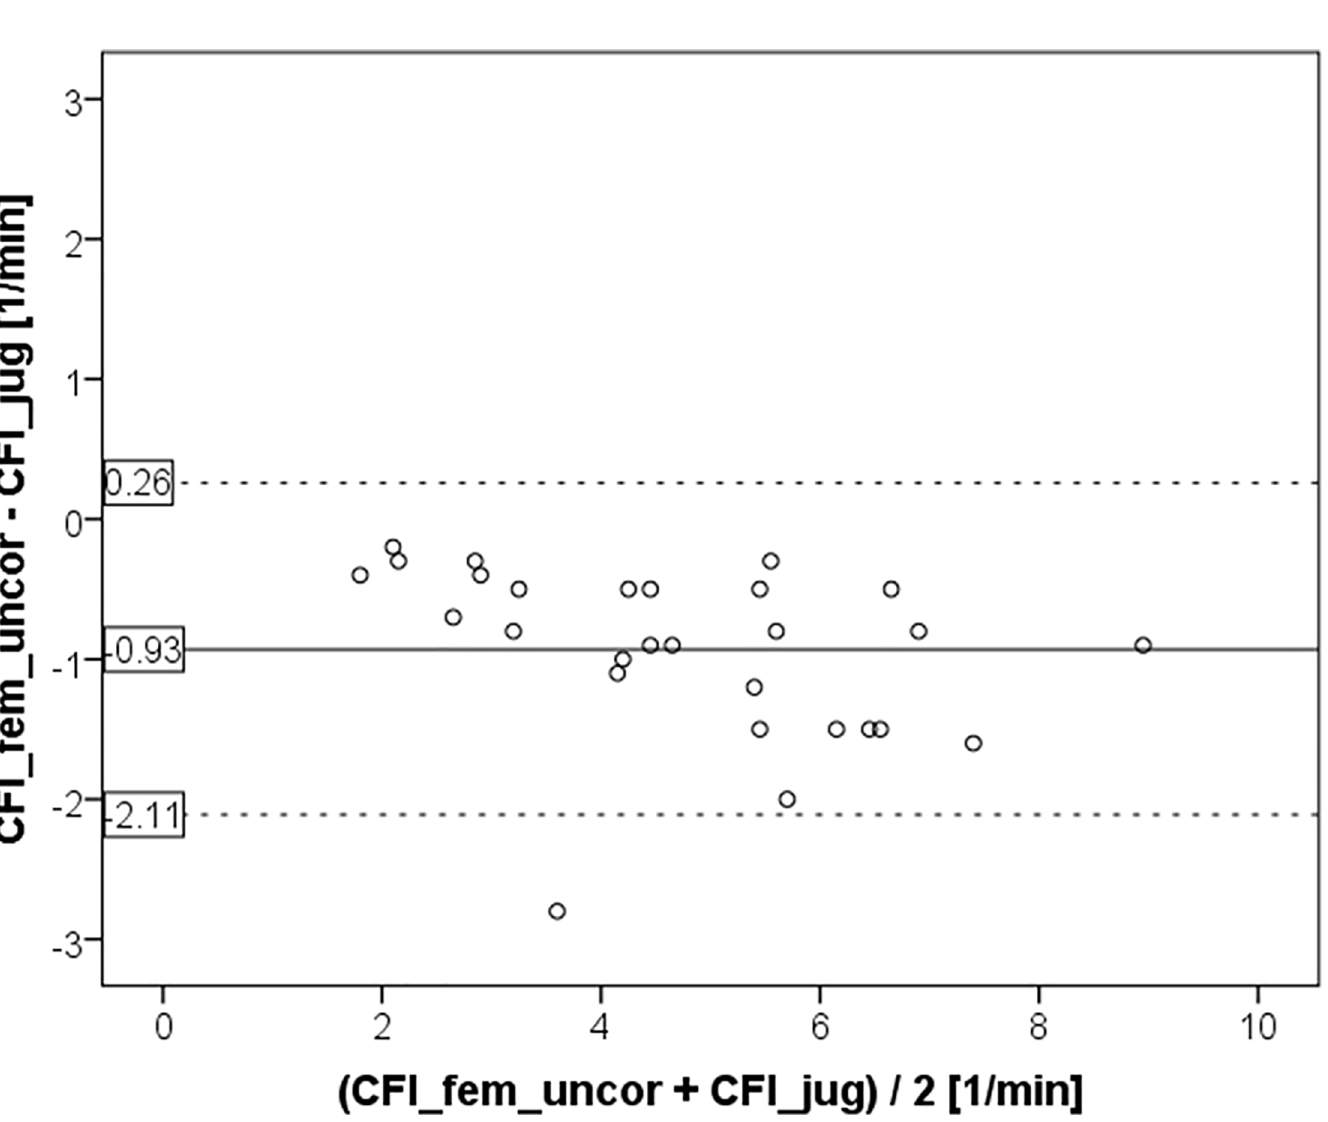
Fig 2. Bland Altman plot comparing cardiac function index CFI_fem_uncor derived from femoral injection without activation of a potential correction by the device to the gold standard measurement CFI_jug using a jugular CVC for indicator injection.